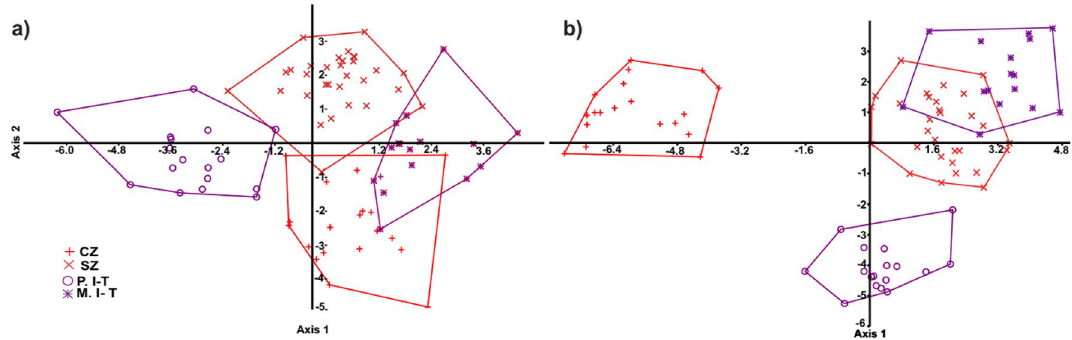
Figure 7. Scatterplot of the two first canonical axes of carapace ( a ) and plastron ( b ) shape variation, showing the distribution of T. graeca populations in Central Iran.